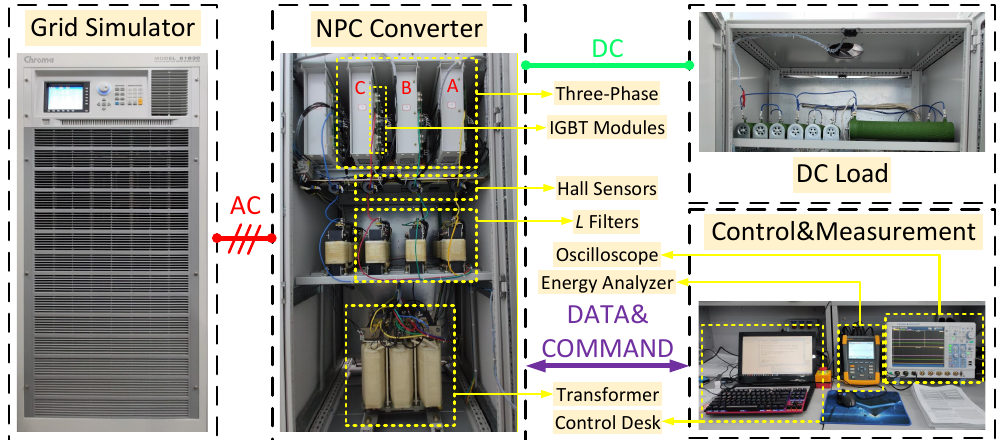
Figure 4. NPC power converter laboratory experimental test